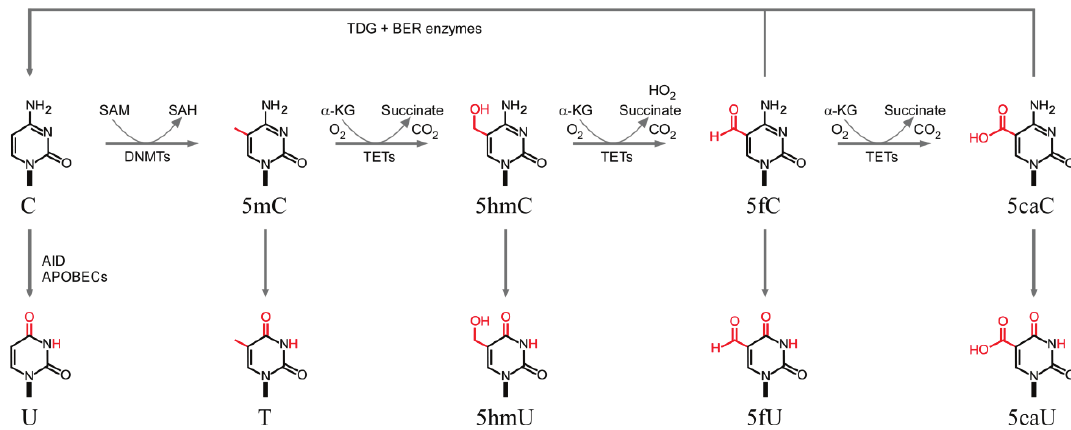
Figure 1. ( Top ) Cytosine methylation and demethylation pathways; ( Bottom ) Products of cytosine and C5-substituted cytosine